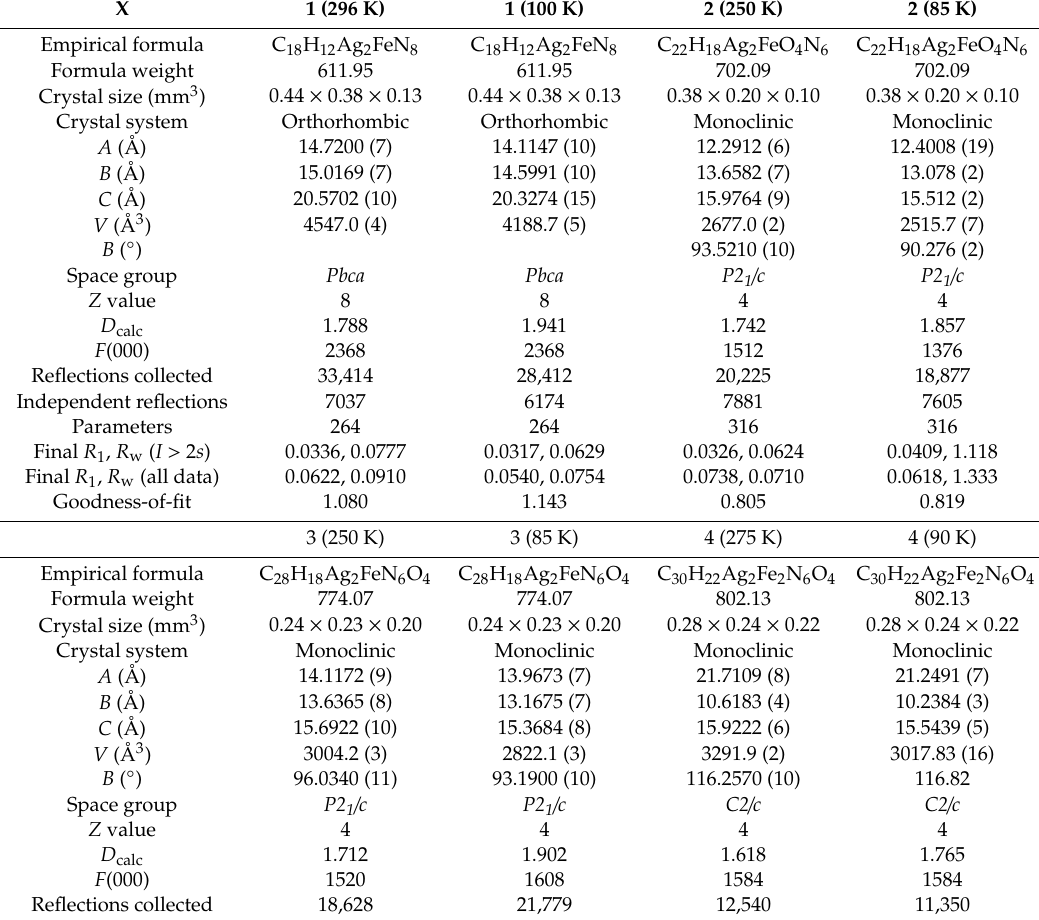
Table 1. Crystal data and structure refinement for compounds 1 – 4